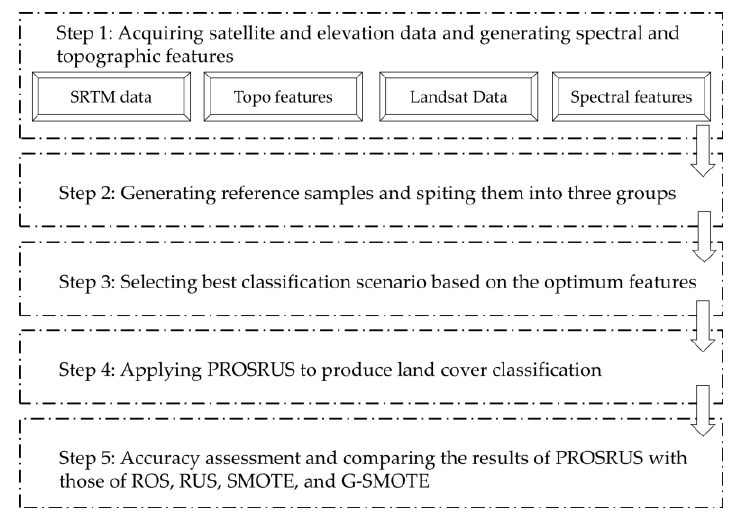
Figure 2. Overall workflow of the study (GEE: Google Earth Engine, PROSRUS: Partial Random Over-Sampling and Random Under-Sampling).